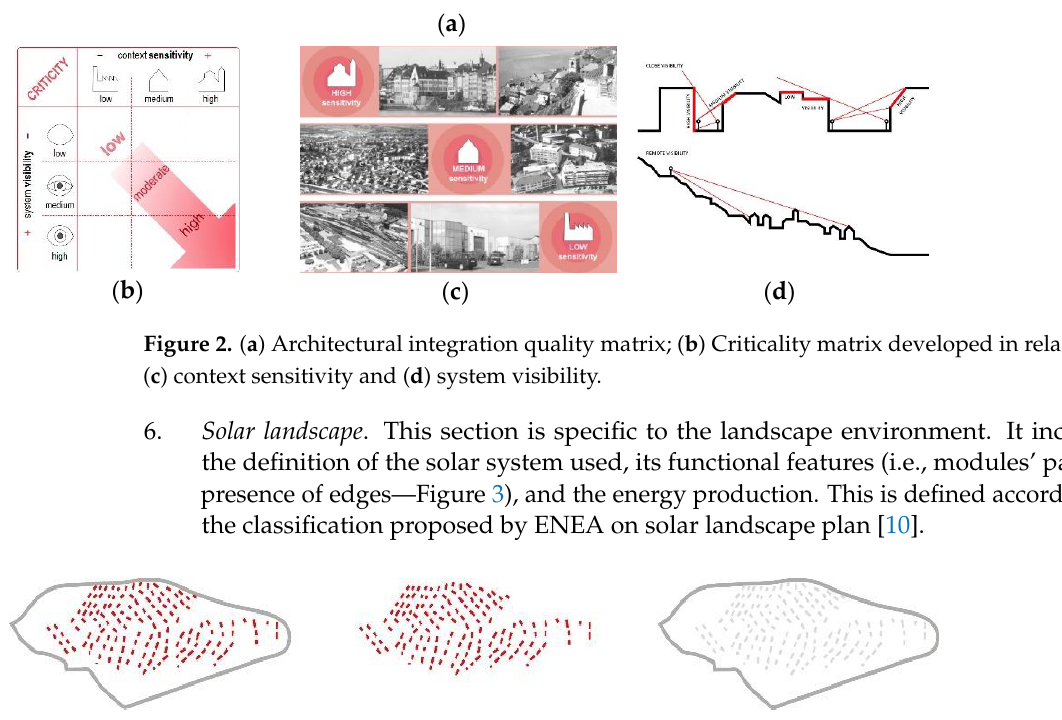
Figure 3. The spatial system as a whole (pattern) (on the left ), the photovoltaic space (in the middle ), and the “pore” space (on the right ).